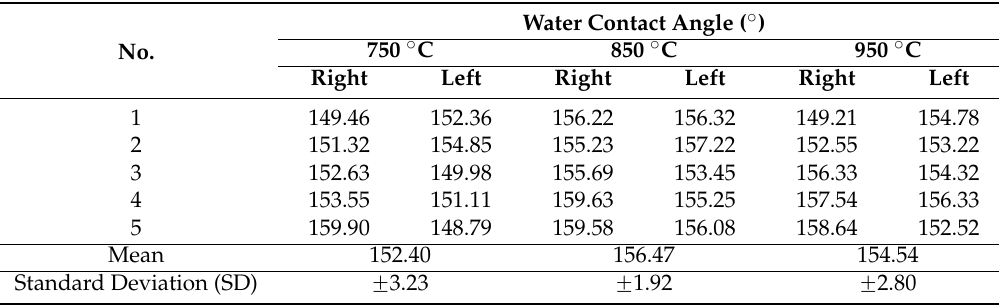
Table 3. The contact angle values for electrospun carbonized PAN fibers.